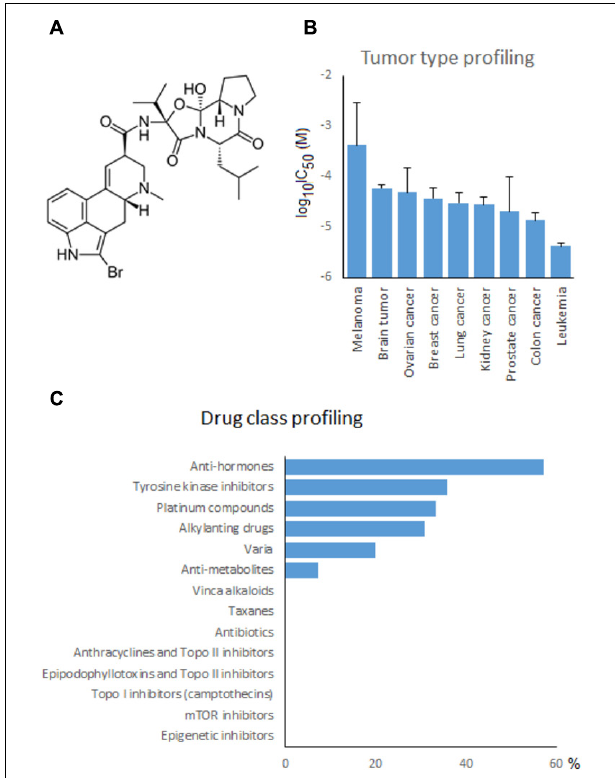
FIGURE 7 | Drug profiling of bromocriptine in the NCI cell line panel. (A) Chemical structure of bromocriptine. (B) Mean log 10 IC 50 values for bromocriptine grouped according to the tumor type of the cell lines. (C) Percentage of classes of standard anticancer drugs, whose log 10 IC 50 values correlated with those for